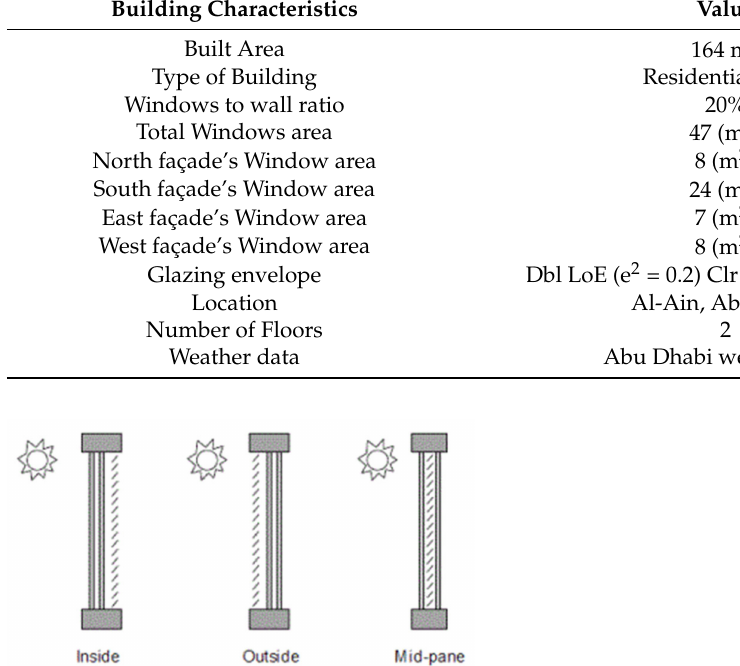
Figure 2. The positioning of windows shading devices (From